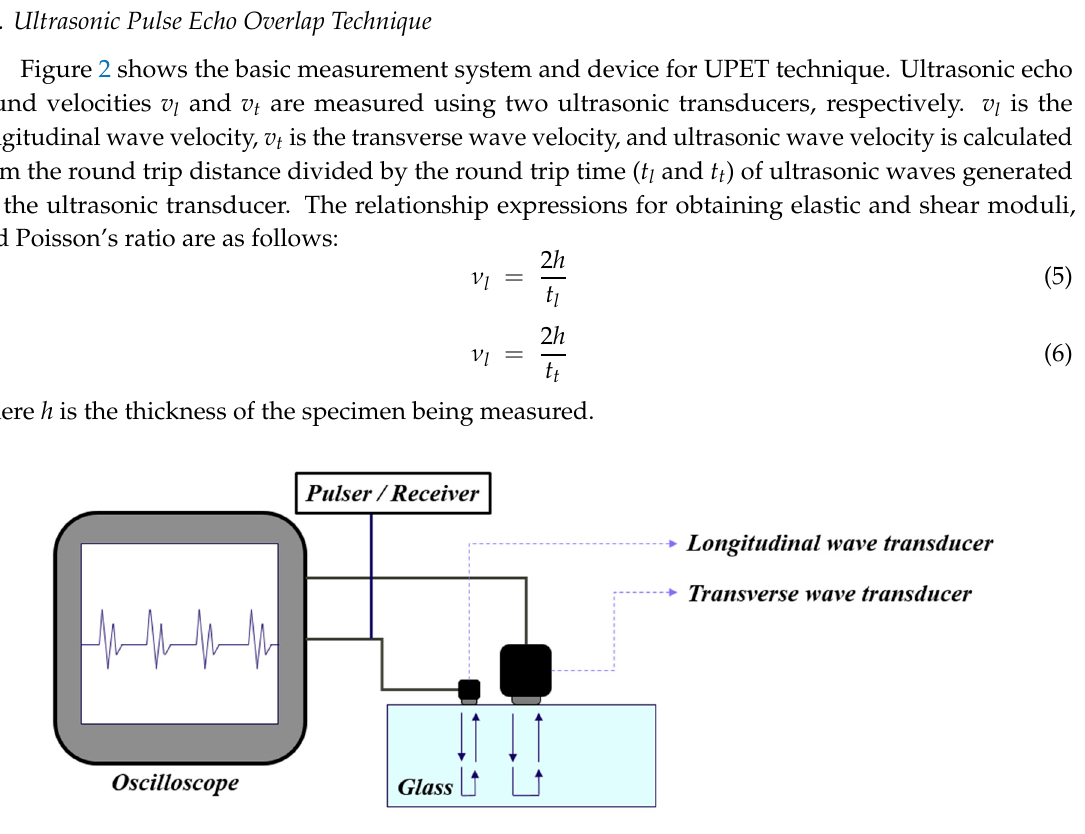
Figure 2. Schematic representation of ultrasonic pulse echo overlap technique.